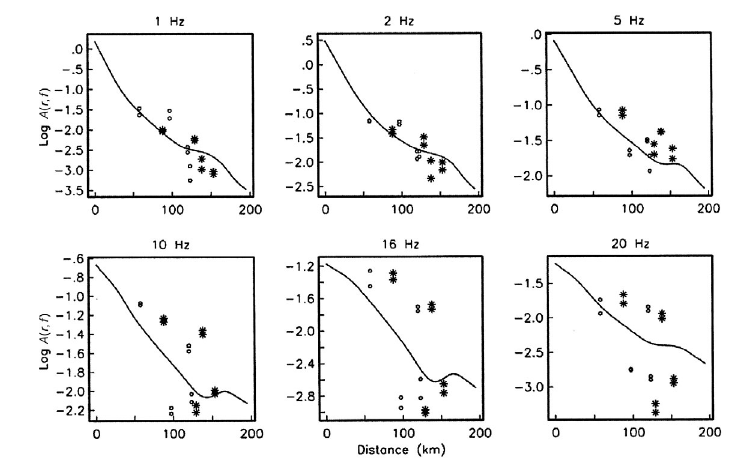
Fig. 5. Nonparametric attenuation functions obtained (solid lines) and observed spectral amplitudes from event 5 (circles) and from event 8